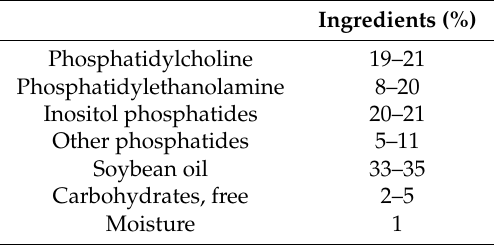
Table 7. Range of components of mixed soy lecithin